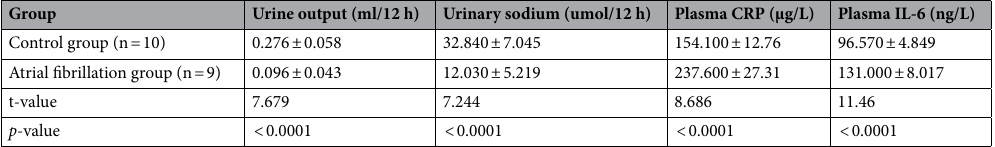
Table 1. Comparison of urine volume, urinary Na + , plasma CRP and IL-6 levels between 2 groups (x ± s).